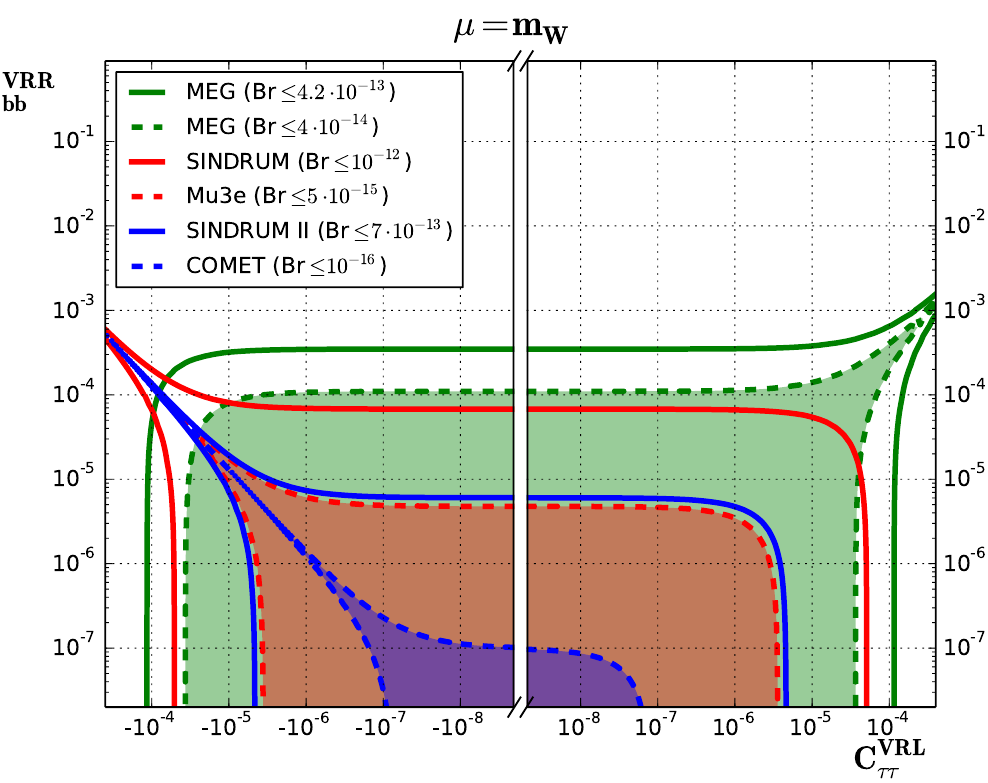
Figure 4. Allowed regions in the C V RL (cid:22) ! e conversion (blue) for current (straight) and future (dashed) experimental